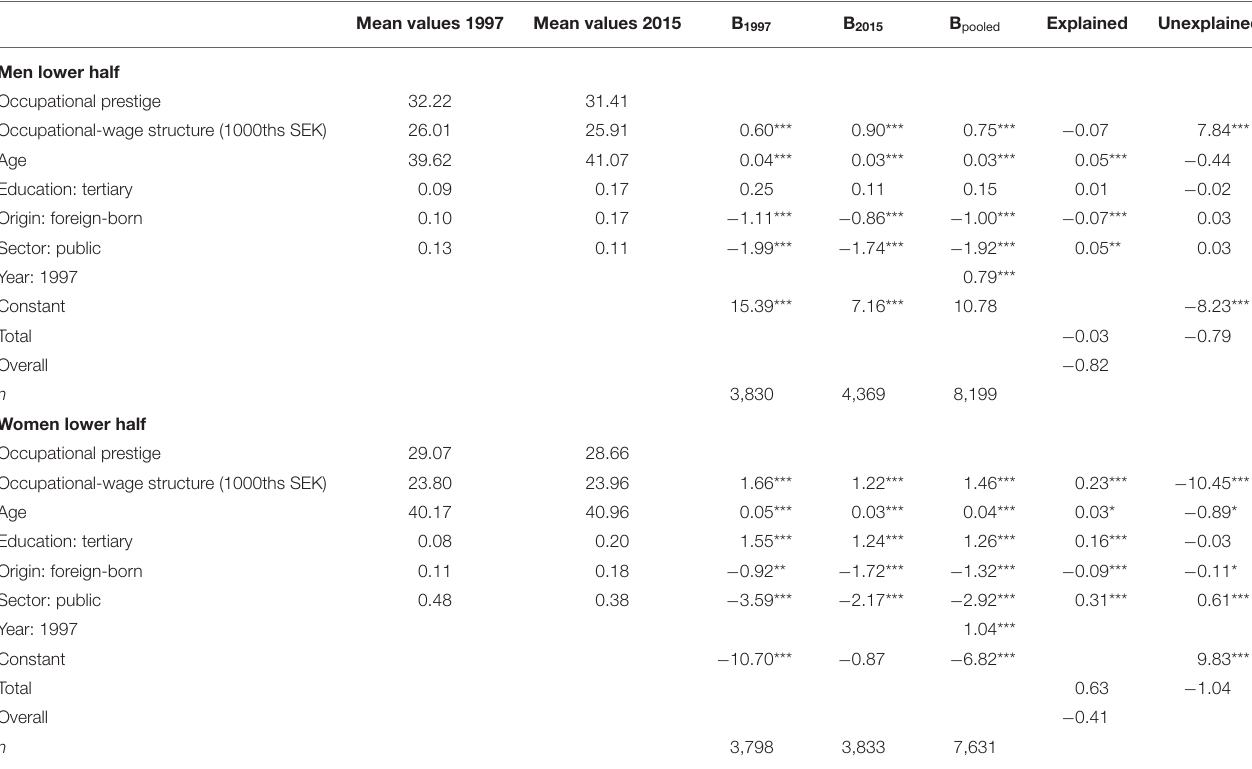
TABLE 4 | Blinder-Oaxaca decomposition of change in occupational prestige for men and women in occupations below the median occupational prestige,